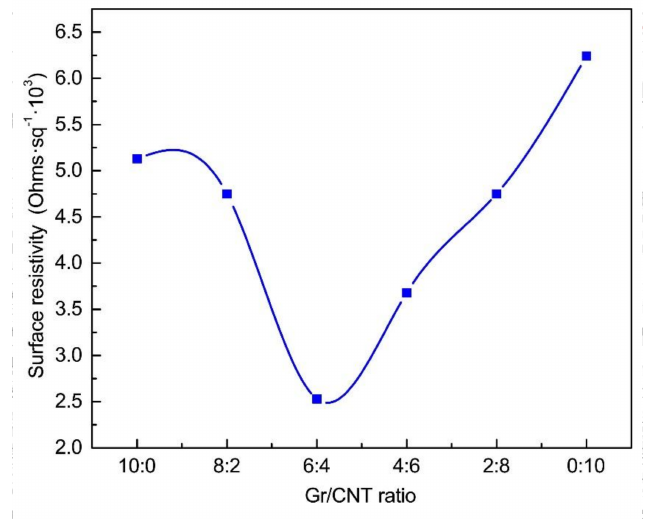
Figure5. SurfaceelectricresistivityofPVA / SA / Gr / CNTnanofibrousmembranesasrelatedtotheGr-CNT ratios. (Control: The surface resistivity of the PVA / SA nanofiber membrane was 7.58 × 10 9 Ω / m 2